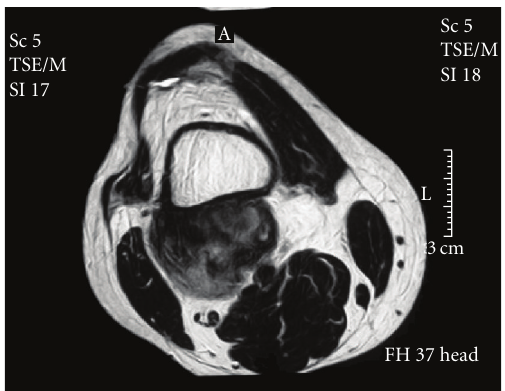
Figure 2: Preoperative MRI showed a relatively dense and well- demarcated ossified mass at a juxtacortical lesion of the distal femur without medullar involvement.